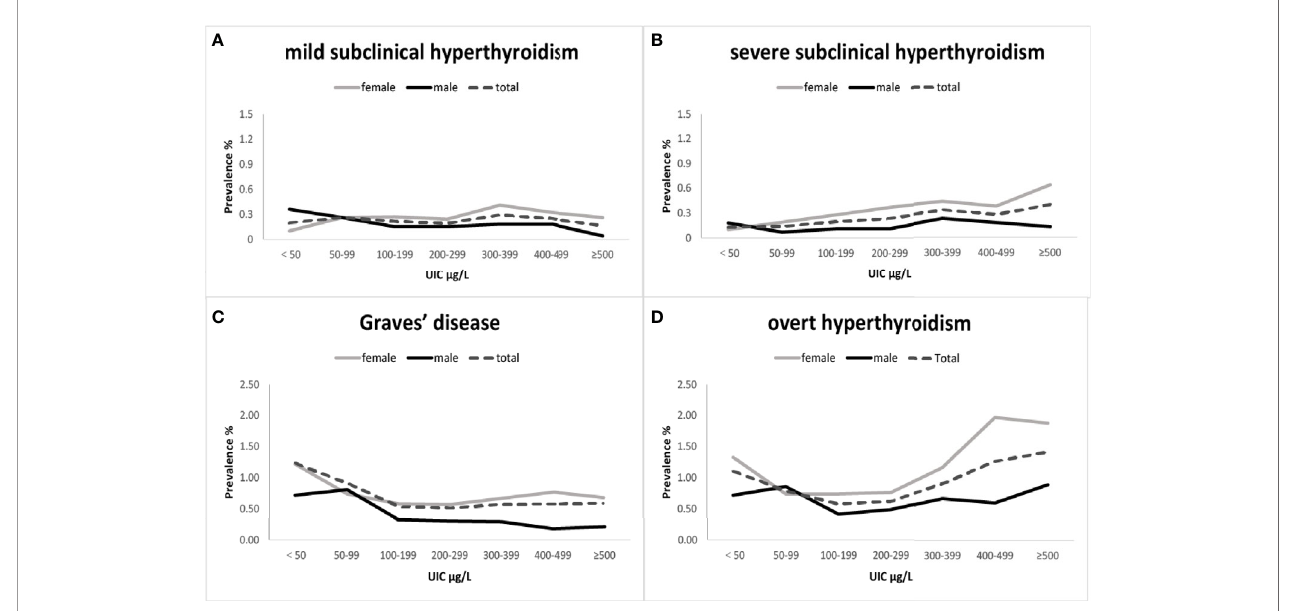
FIGURE 1 | (A) refers to sex- and iodine-speci fi c prevalence of mild subclinical hyperthyroidism; (B) refers to sex- and iodine-speci fi c prevalence of severe subclinical hyperthyroidism; (C) refers to sex- and iodine-speci fi c prevalence of Graves ’ disease and (D) refers to sex- and iodine-speci fi c prevalence of overt hyperthyroidism. Mild subclinical hyperthyroidism [thyroid-stimulating hormone (TSH) 0.1 – 0.26 mIU/L, free thyroxine (fT3) and free triiodothyronine (fT4) within the normal range]. Severe subclinical hyperthyroidism (TSH <0.1 mIU/L, fT3 and fT4 within the normal range). The black line refers to male, the gray line refers to female and the dotted line refers to total. UIC, Urinary iodine